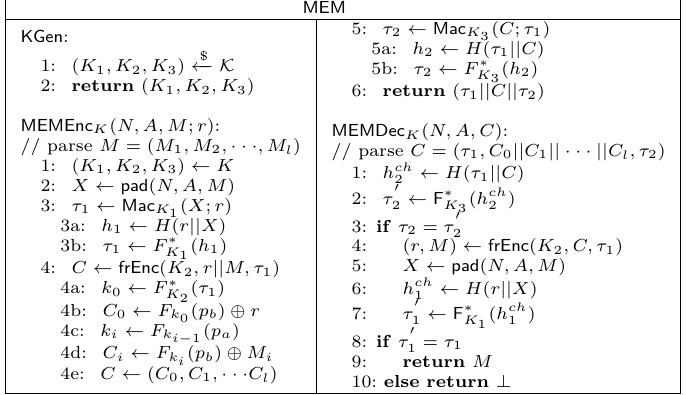
Table 8: The MAC-then-Enc-then-MAC ( MEM ) Scheme